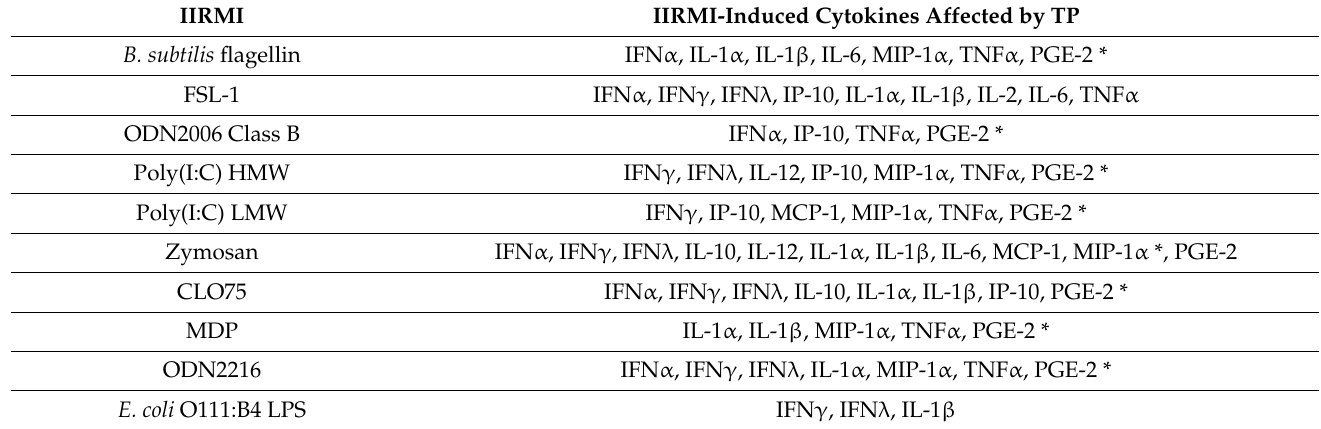
Table 4. Teriparatide Affects Cytokines Induced by Innate Immune Response Modulating Impurities (IIRMIs). Individual IIRMIs and IIRMI-triggered cytokines in which expression is affected by the presence of 25 μ g/mL of teriparatide (TP) are summarized in the table. In the presence of TP, all cytokines shown in the table are inhibited, except for the cytokines highlighted with an asterisk (*); levels of these cytokines are higher in the presence of TP. Statistical analysis included a two-sided Wilcoxon test.